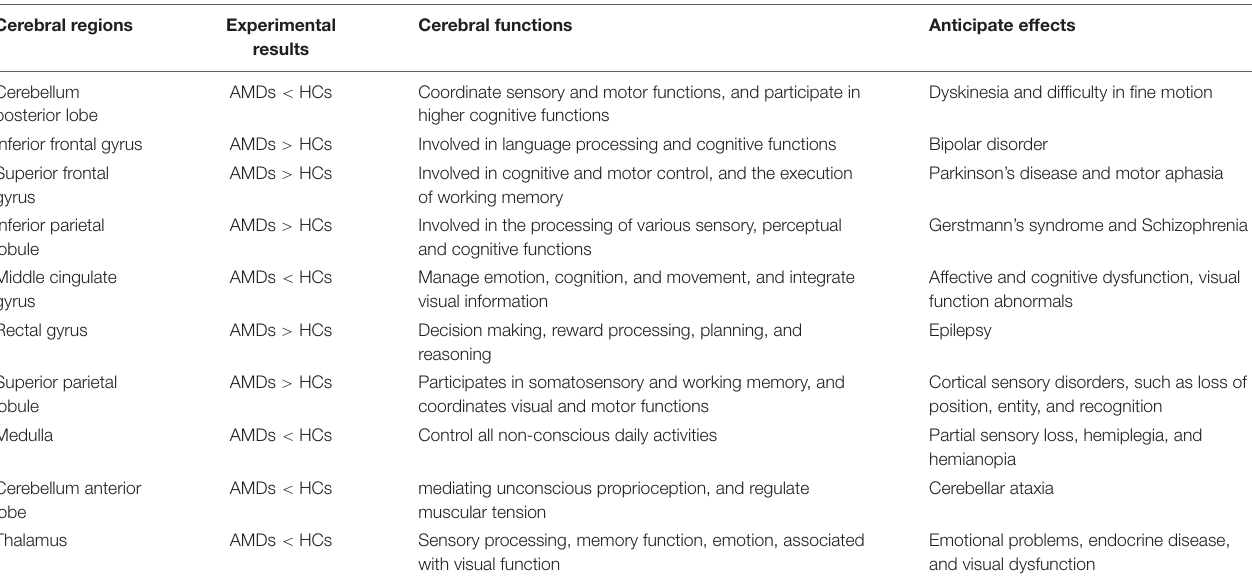
TABLE 4 | Alternation of cerebral regions and its potential